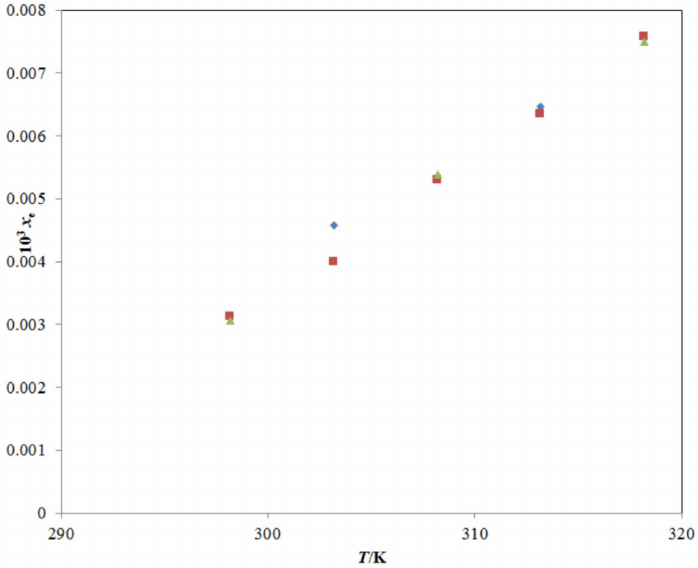
Figure 2. A graphical comparison of TRV solubility in neat water with reported values at different temperatures; the symbol represents the experimental TRV solubility in neat water; the symbol represents the reported solubility values of TRV in neat water taken from reference [27]; the symbol represents the reported solubility values of TRV in neat water taken from reference [1].